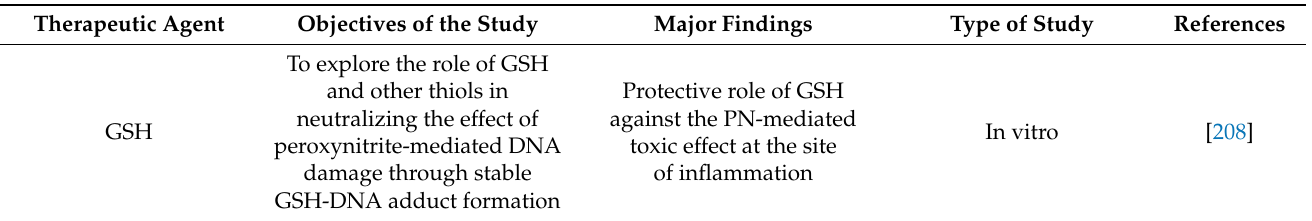
Table 5. Published studies supporting GSH supplementation in